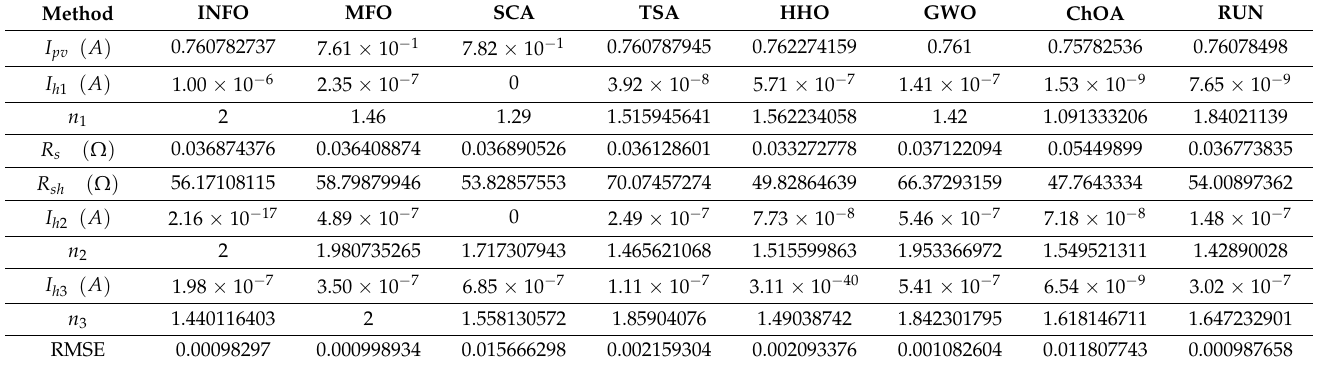
Table 5. The TDMSC’s identified parameters at the best RMSE.